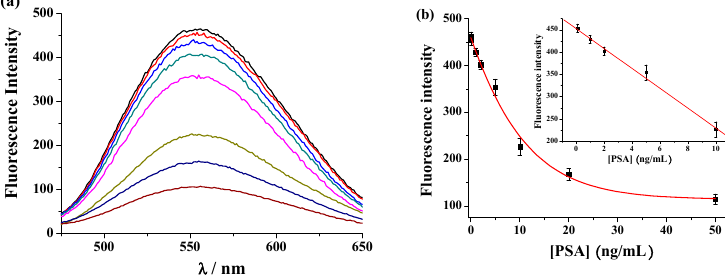
Figure 5. The emission spectra ( a ) and fluorescence intensity ( b ) for assays of different concentrations of PSA (from top to bottom: 0, 0.1, 1, 2, 5, 10, 20 and 50 ng/mL).